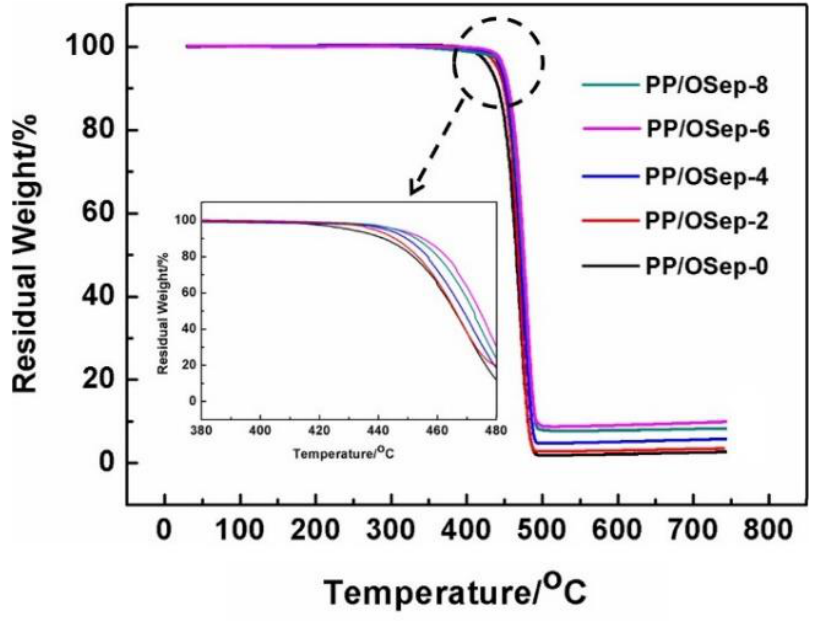
Figure 11. TG curves of PP/OSep nanocomposites with different OSep contents. Table 3. DSC scan results of PP/OSep